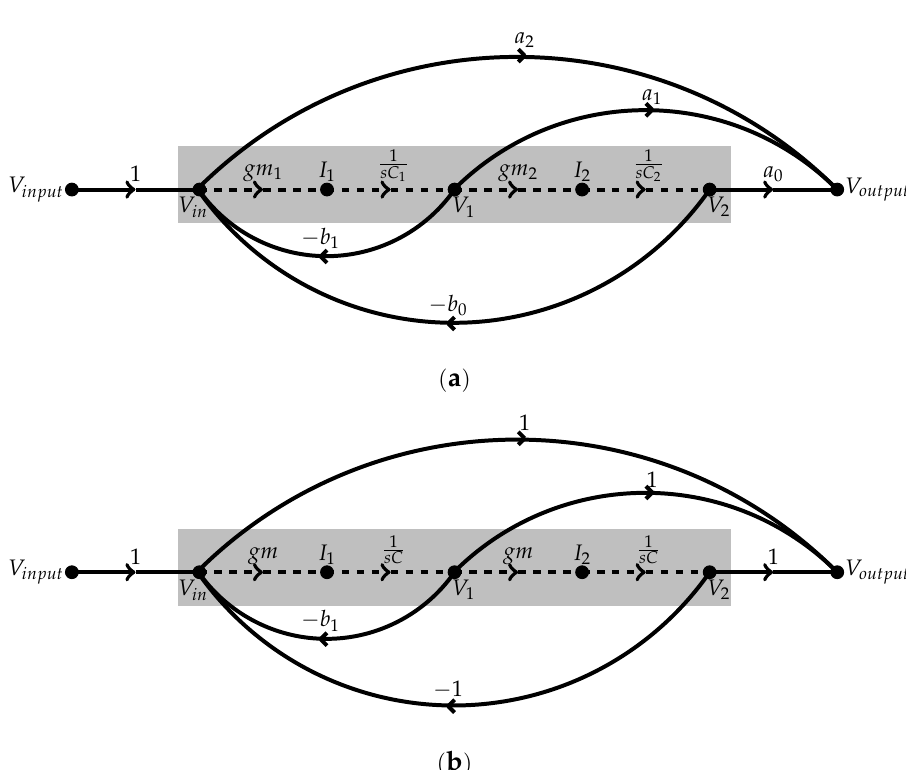
Figure 2. SFGs in controllable canonical form of a biquad gm-C filter: ( a ) complete and ( b ) simplified